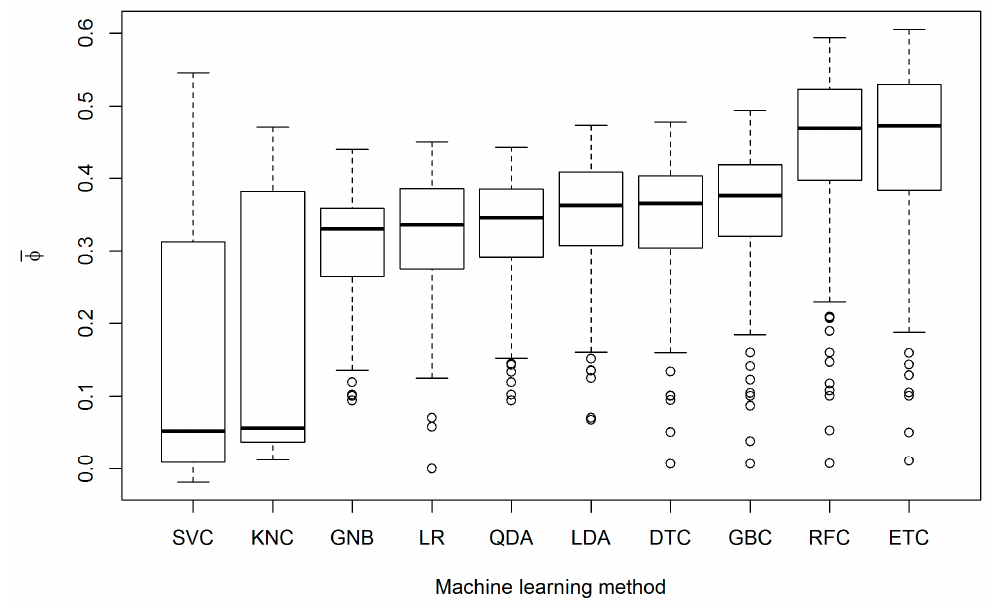
Figure 5. Box plots of mean phi coefficients ( φ ) of FDMs generated by MLAs. Box plots show median plus upper and lower quartiles for mean phi coefficients of all FDMs generated by a given algorithm. Minimum and maximum values are indicated by the upper and lower whiskers (1.5 × interquartile range). Circles are outliers. See Table 3 for MLA codes.